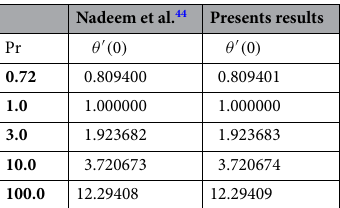
Table 1. Previous studies comparison of θ ′ ( 0 ) values, when M = γ = 0 = ε